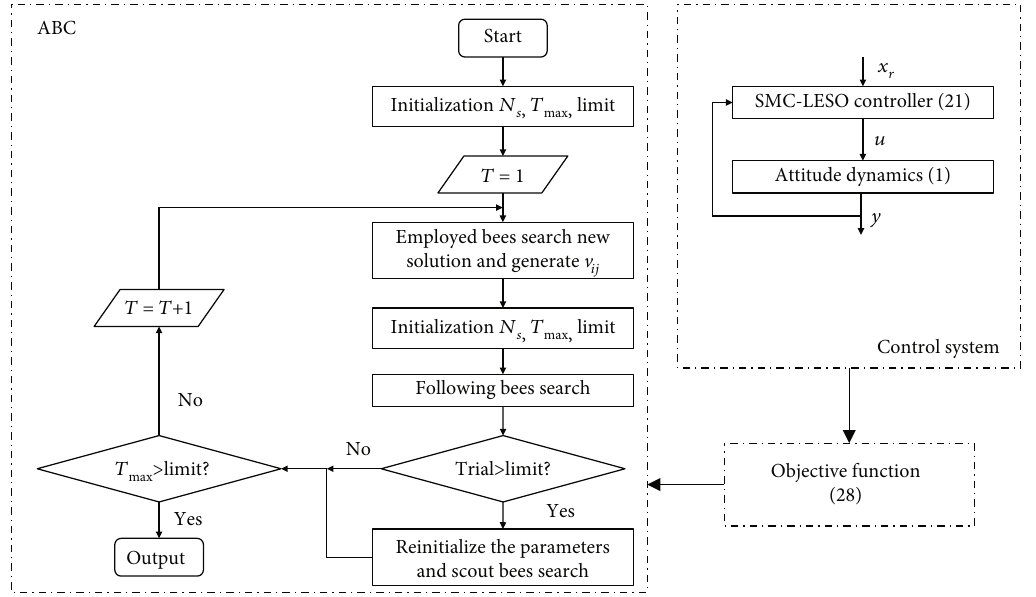
Figure 17: Flow chart of ABC in parameter tuning (explain of the variables can be found in Ref. Table 3: Optimal parameters of SMC-LESO. Parameters